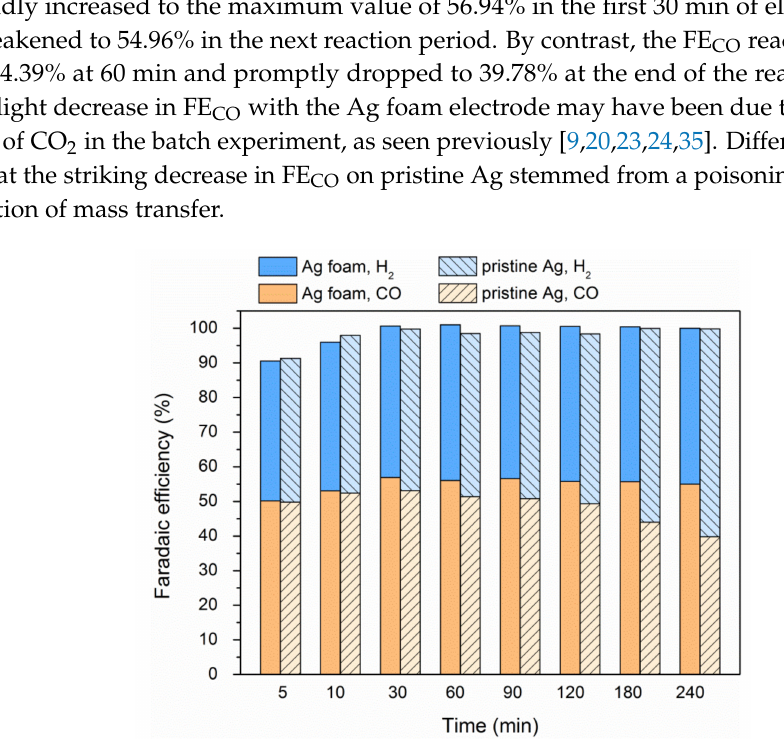
Figure 10. Faradic efficiency of CO and H 2 at different time intervals during polarization at − 0.65 and − 0.72 V with H 2 :CO = 1 for Ag foam and pristine Ag, respectively. Experimental conditions: anolyte, 0.5 M NaOH; catholyte, CO 2 -saturated 0.1 M KHCO 3 ; 25 ◦